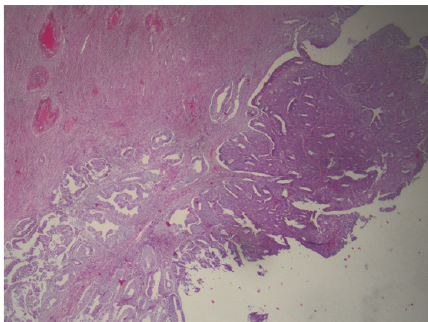
Figure 3: Immunostain: positive expression of p53 in endometrial carcinoma.